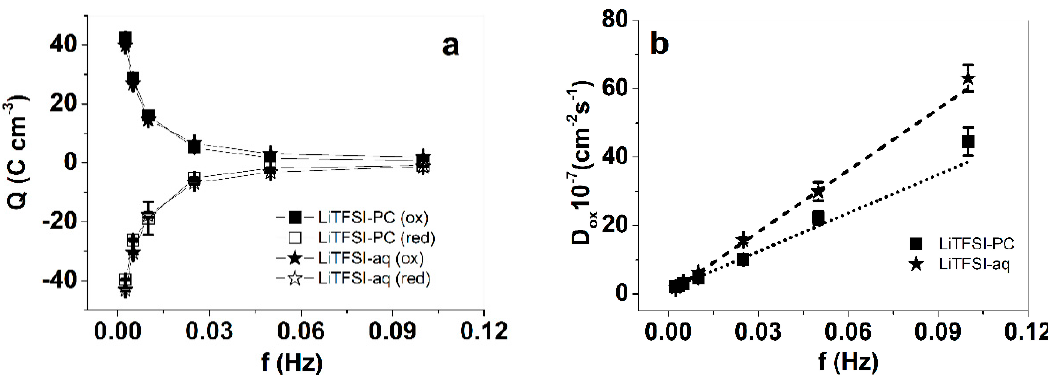
Figure 5. PPyPIL bulk films in potential step measurements at applied frequencies 0.0025 Hz to 0.1 Hz operating at potential 0.65 V to − 0.2 V in LiTFSI-PC ( ■ (ox), □ (red)) and LiTFSI-aq ( ★ (ox), ☆ (red)) electrolytes. The charge densities Q against applied frequency f are shown in ( a ) and the diffusion coefficients at oxidation D ox applying Equations (1) and (2) are shown in ( b ).